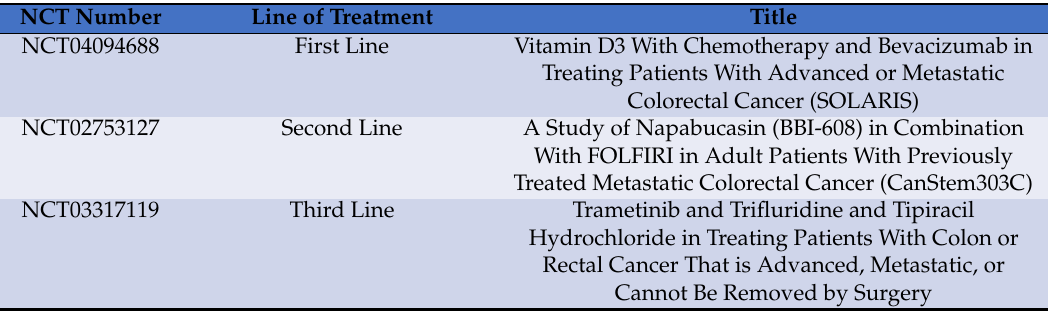
Table 1. Selection of colorectal cancer trials activated in City of Hope Community